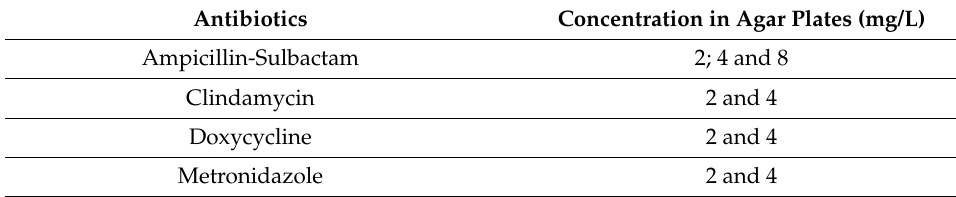
Table 1. Antibiotic plate concentration.